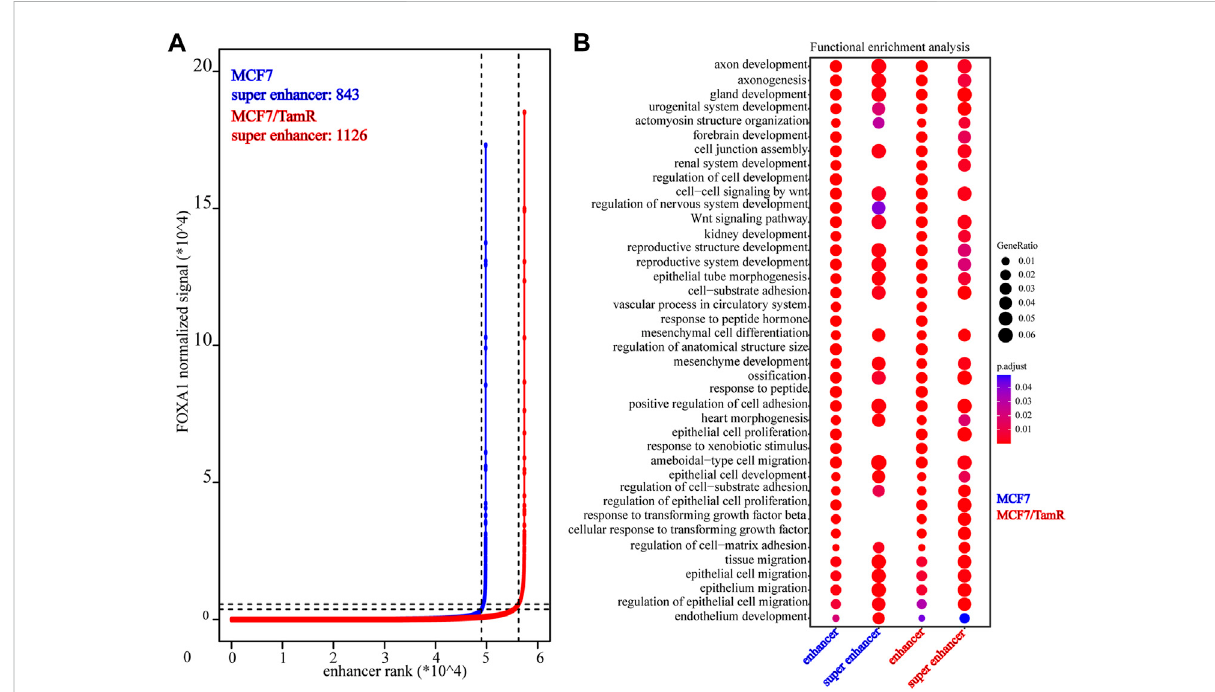
The identi fi ed super enhancers in MCF7 and MCF7/TamR cells. (A) Distribution of FOXA1 normalized ChIP-seq signal and the corresponding enhancer rank in MCF7 and MCF7/TamR cells, red line represents MCF7/TamR cells and the blue line represents MCF7 cells. (B) Dot plot of the